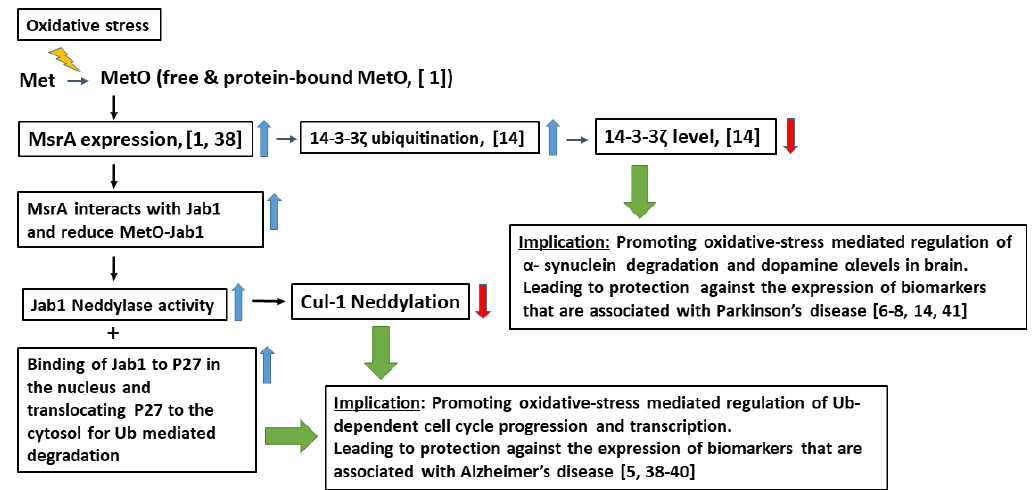
Figure 7. A summary of the proposed events and their link to neurodegeneration diseases. The details of the figure are presented under the Section 4. The blue arrows indicate an “upregulation” and the red arrows indicate a “downregulation” phenomenon.